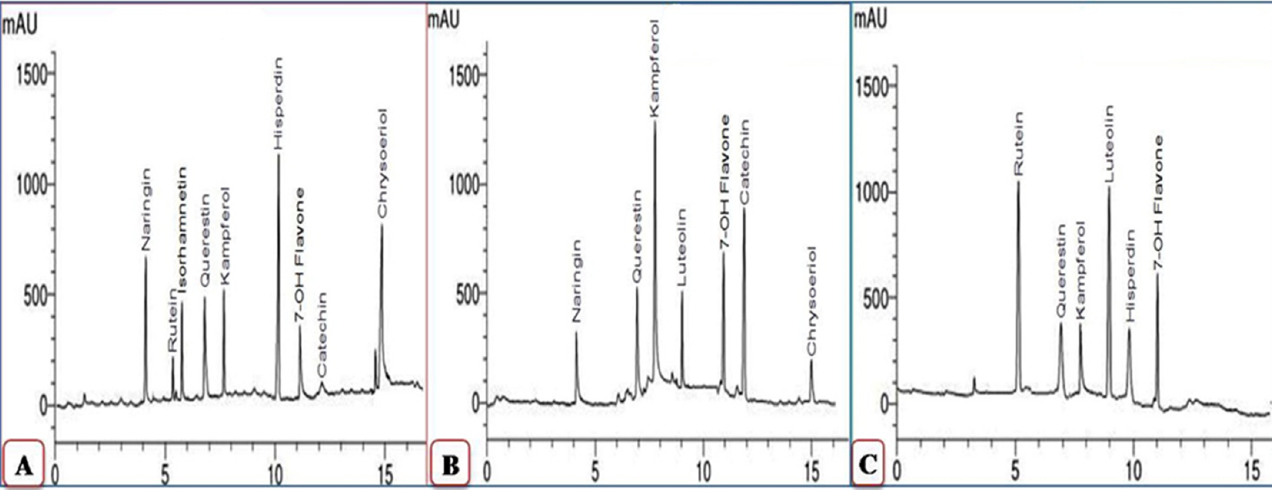
Figure 6. HPLC chromatograms of flavonoid compounds in ethanolic extract of the squash plant. Mock-inoculated plants ( A ), CMV- inoculated plants at 6 dpi ( B ), and CMV- inoculated plants at 12 dpi ( C ).